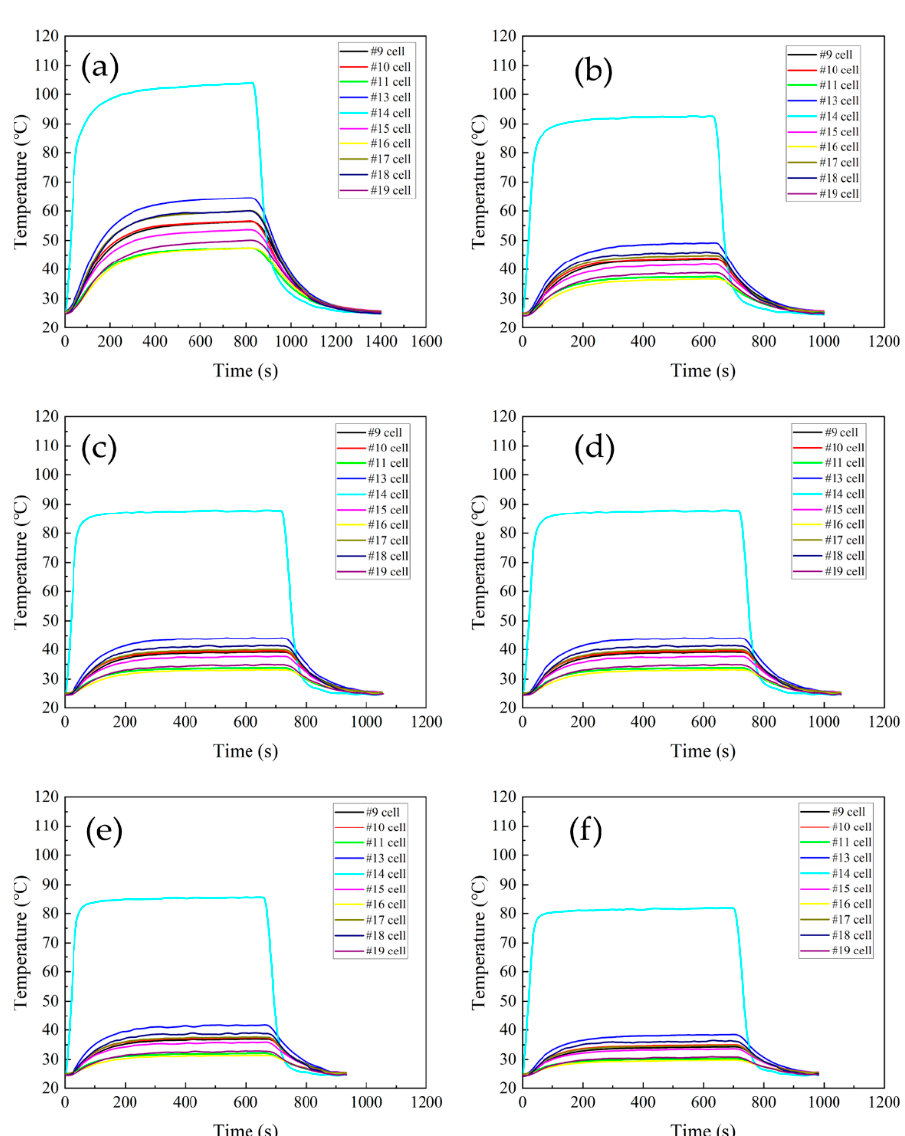
Figure 10. The change in battery module temperature with time at different flow speeds. ( a ) 0.2 m/s,